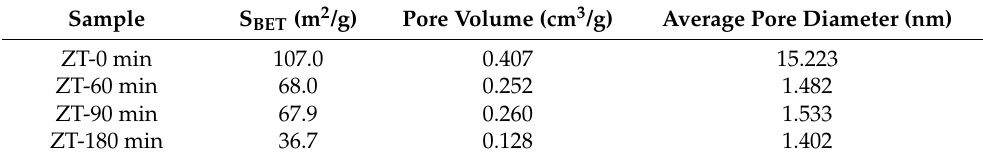
Table 2. S BET , pore volume and average pore diameter of Z100T200 at different catalytic time.